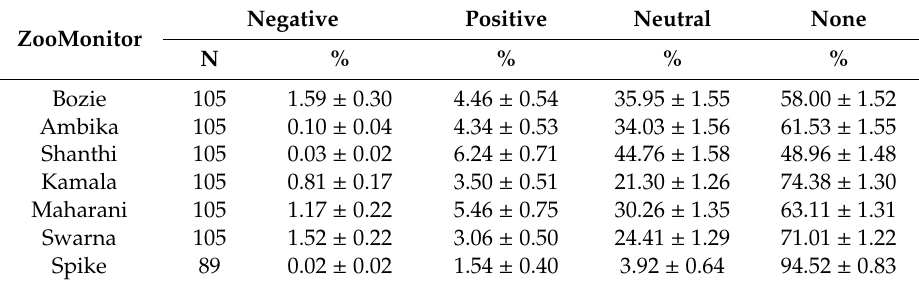
Table 4. ZooMonitor (30 min focal) data (% ± standard error) for social interactions per elephant, rated on each two-minute interval as “Negative”, “Positive”, “Neutral” if elephants were within one body length of each other or “None”. Mean weekly proportion of time for each type of social interaction was determined for N number of weeks.